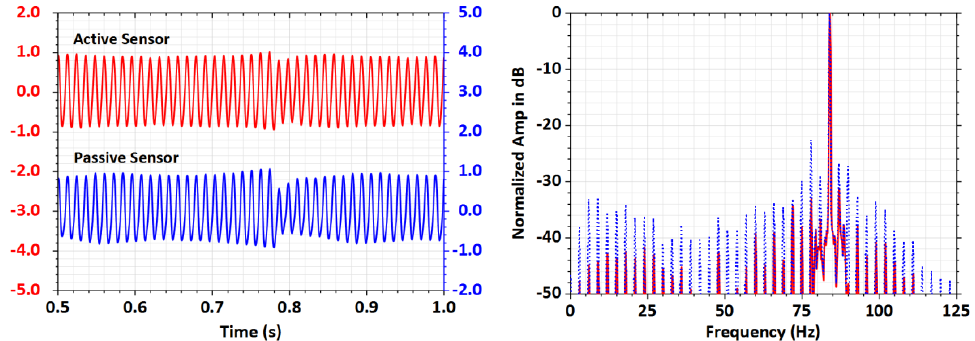
Figure 19. Outputs of a rotor with broken end-ring segment.